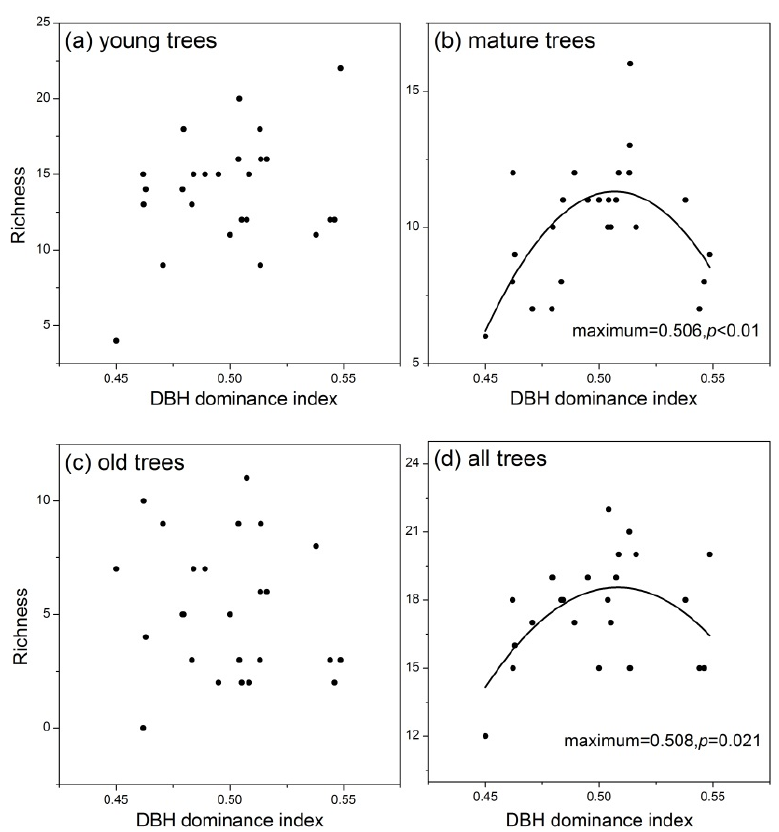
Figure 5. Relationship between tree species richness and spatial aggregation index of DBH dominance index for all trees and different growth stage: ( a ) young trees; ( b ) mature trees; ( c ) old trees; ( d ) all trees. If the relationship is significant ( p < 0.05), the regression line is plotted, with unimodal relationship examined by the Mitchell ‐ Olds and Shaw (MOS) test.